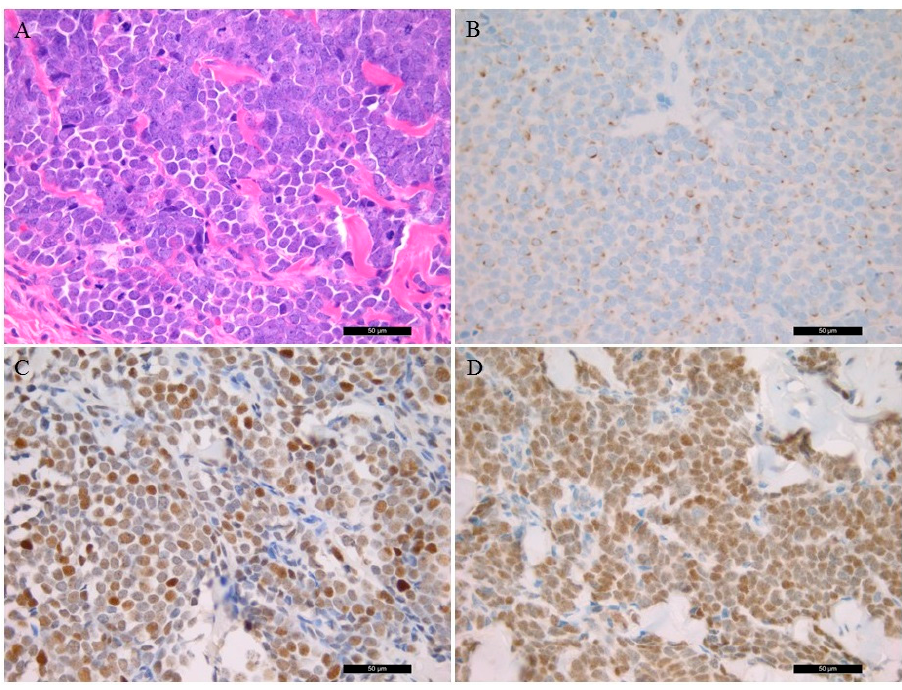
Figure 1. Histological and immunostaining of Merkel Cell Carcinoma (40×). ( A ) Conventional histological hematoxylin and eosin-stained characteristics of the tumor sample; ( B ) immunohistochemistry of CK20 protein; ( C ) p53 immunostaining; ( D ); Merkel cell polyomavirus large T antigen-positive tumor sample.